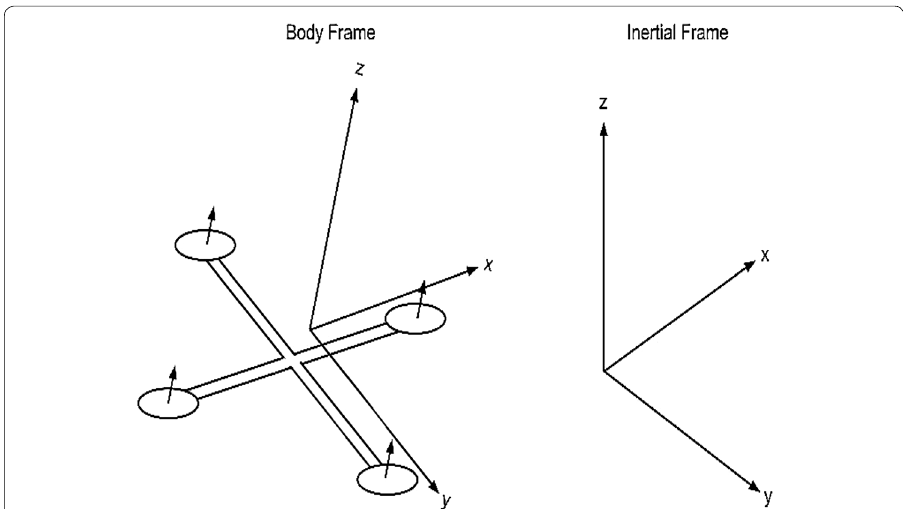
Fig. 6 Body frame and inertial frame axis